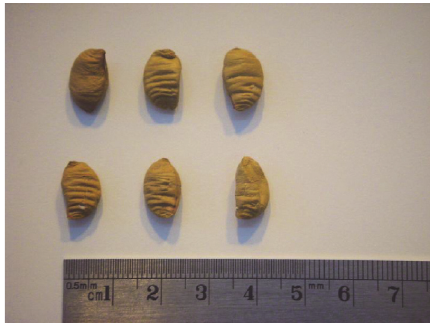
Figure 1: Appearance and size of cha˜nar seeds (kernel).